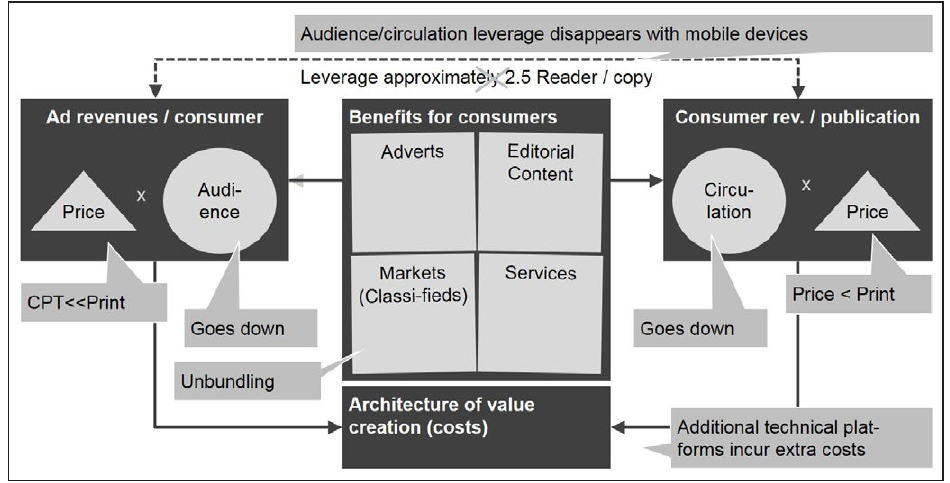
Figure 3: Schematic view on the traditional newspaper business model and its challenges. Source : Own